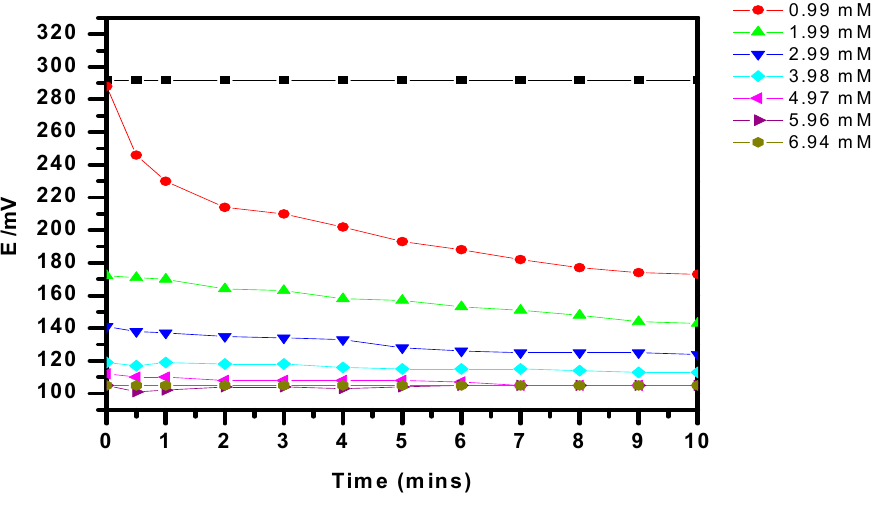
Figure 7. Evolution of electrode potential (vs. Ag/AgCl) as a function of time for various concentrations of urea in non-buffered solutions.